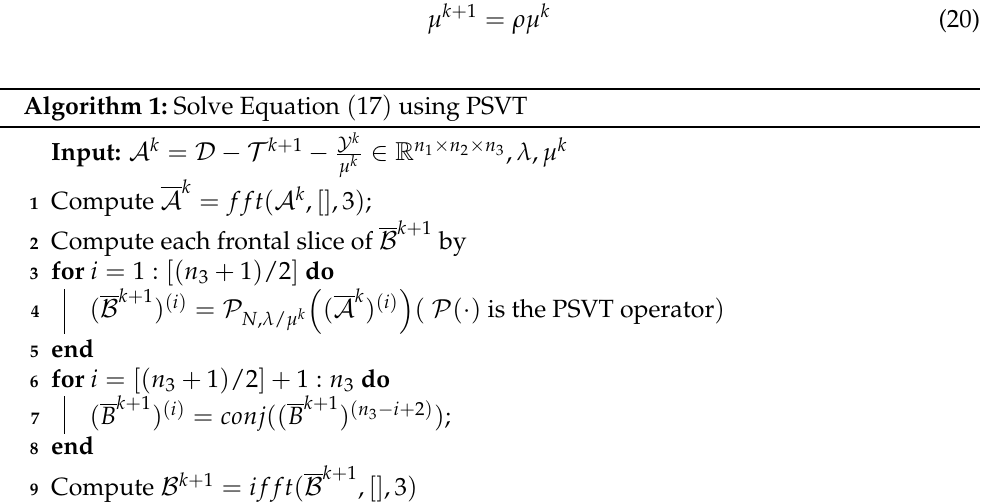
Algorithm 1: Solve Equation ( 17 ) using